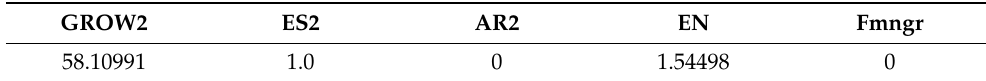
Table 3. Parameters of the ignition growth model.